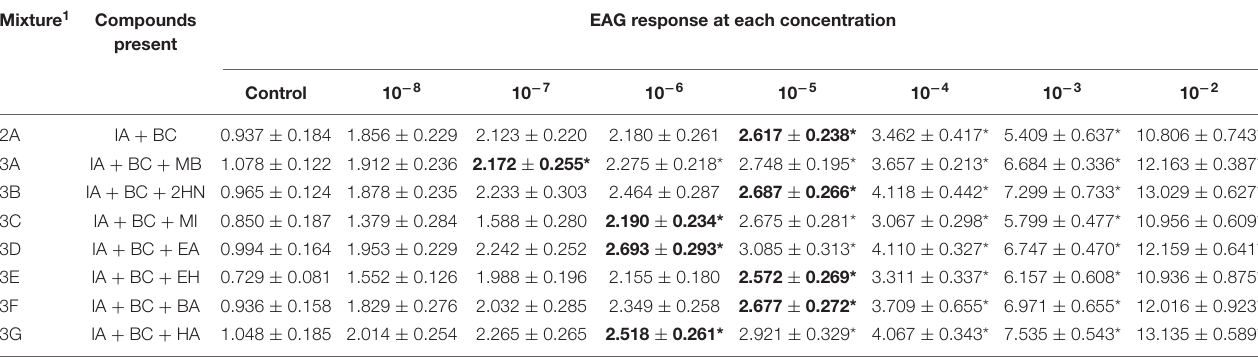
TABLE 2 | Electroantennogram (EAG) responses (mean ± SEM) of male D. suzukii to different concentrations of mixtures with 2-3 compounds. Mixture